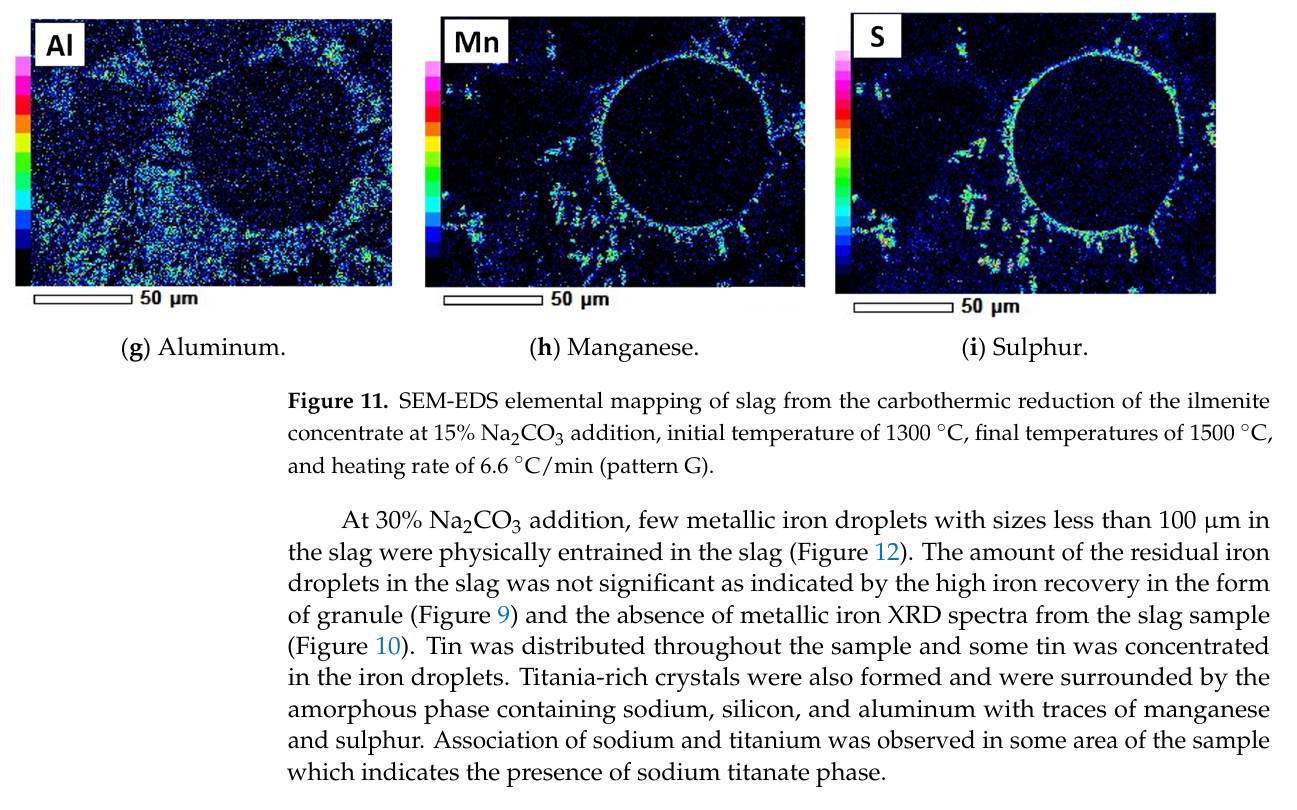
ple which indicates the presence of sodium titanate phase.